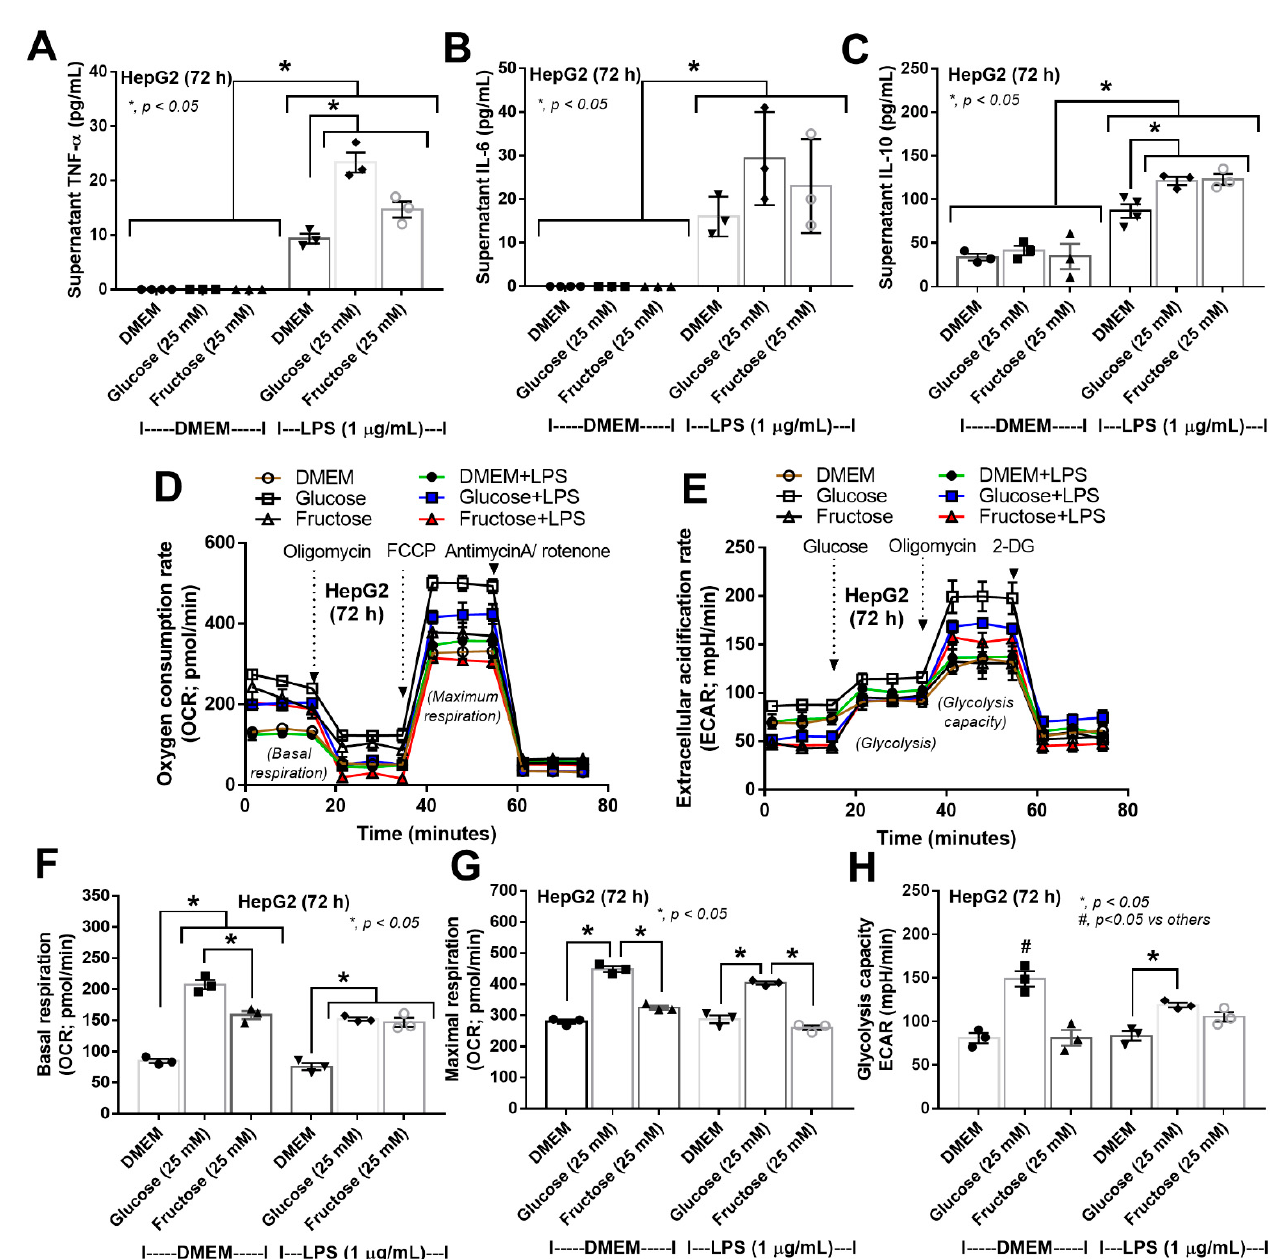
Figure 7. Characteristics of HepG2-2 cells (hepatocytes) after 72 h of activation by medium control (DMEM), glucose or fructose with and without lipopolysaccharide (LPS) as indicated by supernatant cytokines (TNF- α , IL-6, and IL-10) ( A – C ), extracellular flux analysis of mitochondrial function and extracellular acidification rate (ECAR) and, respectively, ( D – F ) and graph presentation of maximal respiration of OCR ( G ) and glycolysis capacity of ECAR ( H ) are demonstrated. Independent triplicate experiments were performed for all experiments.